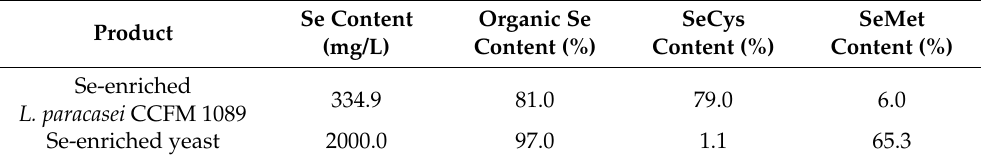
Figure 2. Results of Selenium (Se) form analysis. The four strains compared are Lactobacillus paracasei CCFM 1089, Lactobacillus plantarum CCFM 8610, Lactobacillus casei FJSSZ4-L2, and Lactobacillus casei 34-3, respectively. Table 3. Enrichment of organic Se in products.